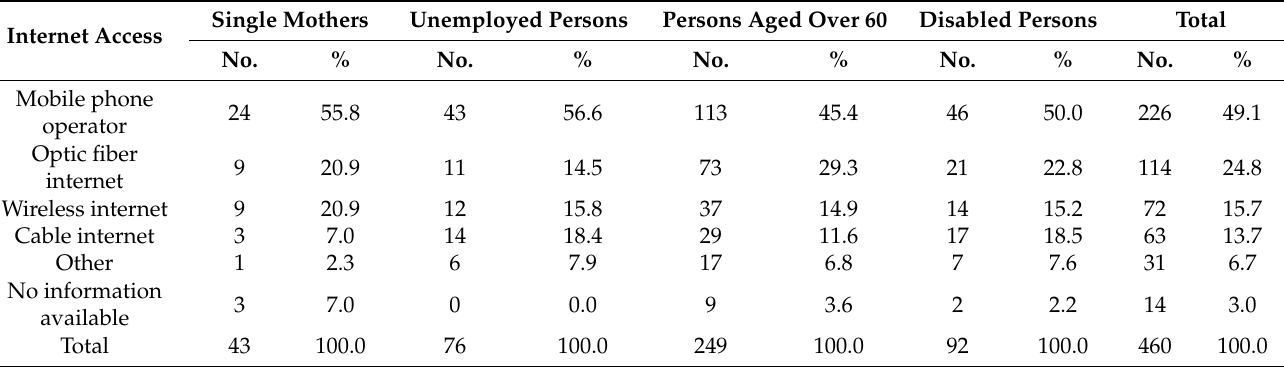
Table 11. Internet access by social status of the respondents ( n =